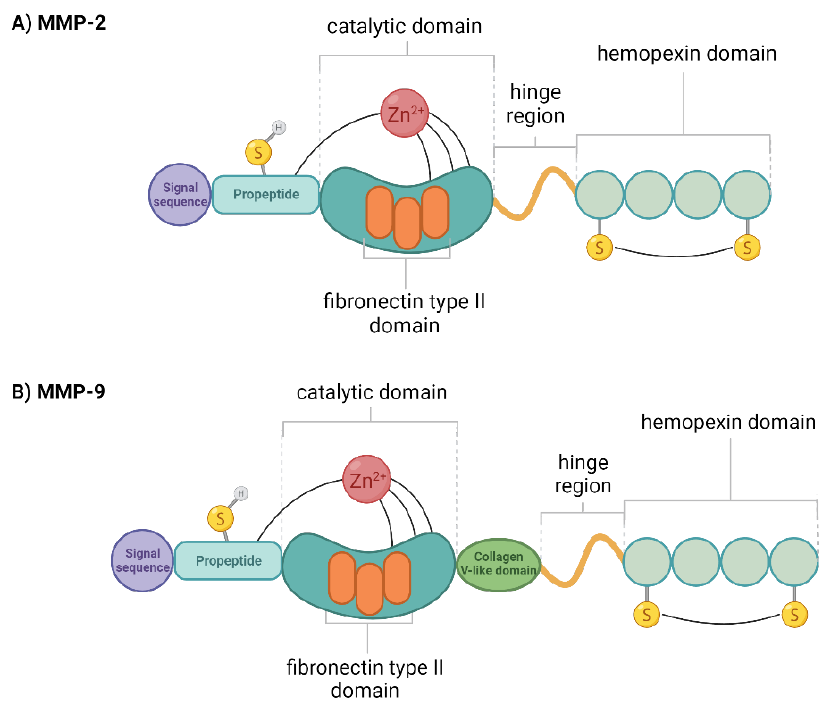
Figure 1. Diagram of the domain structure of ( A ) gelatinase-A (MMP-2) and ( B ) gelatinase-B (MMP-9). Created with BioRender.com.